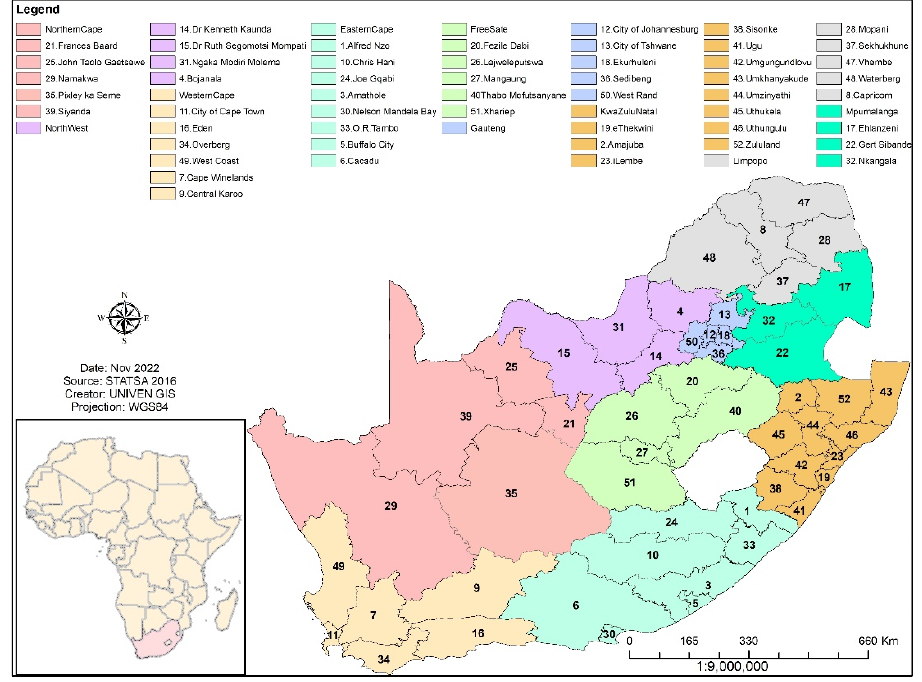
Figure 2. Map of South Africa case study.